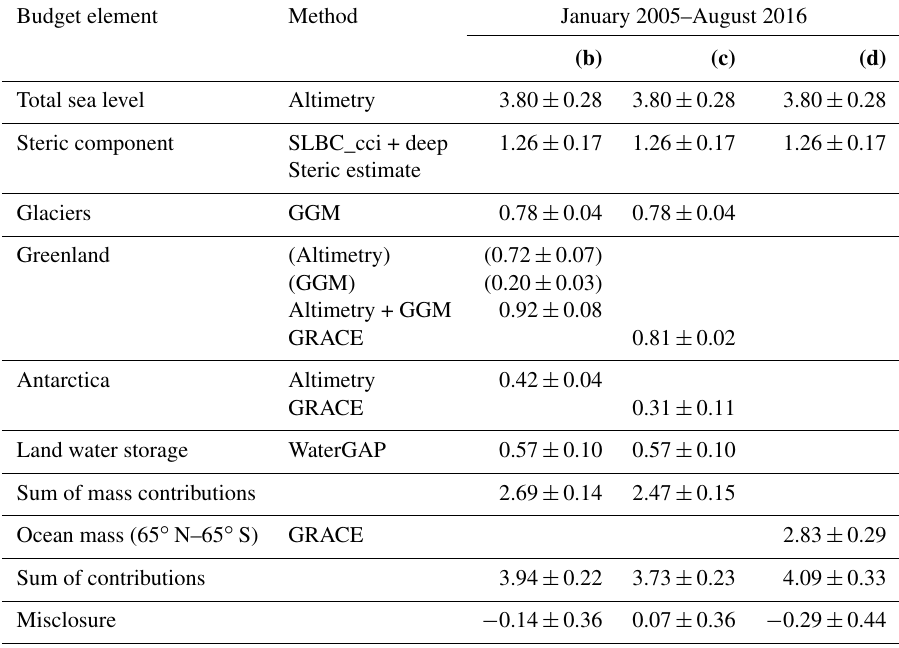
Table A1. Same as the last three columns of Table 4 but for the alternative period of January 2005–August 2016, when the Argo